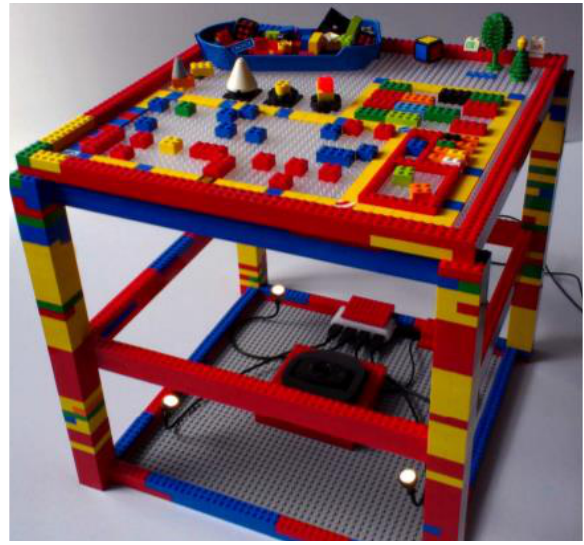
Figure 32. A tangible rhythm sequencer with parameter controls, camera, illumination [55].